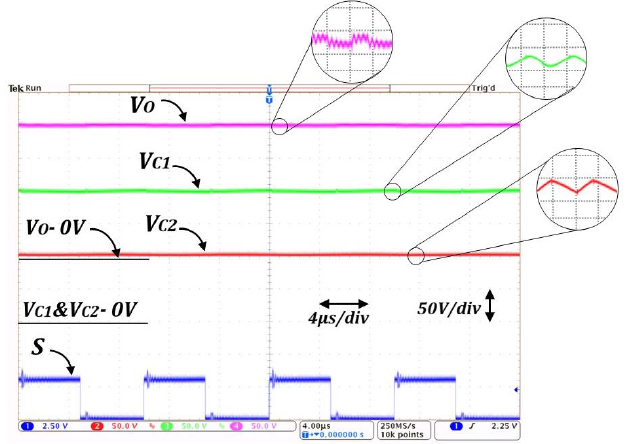
Figure 26. Switching function “ s ”, capacitors and output voltage ( V g = 100 V , V o = 200 V , P o = 400 W